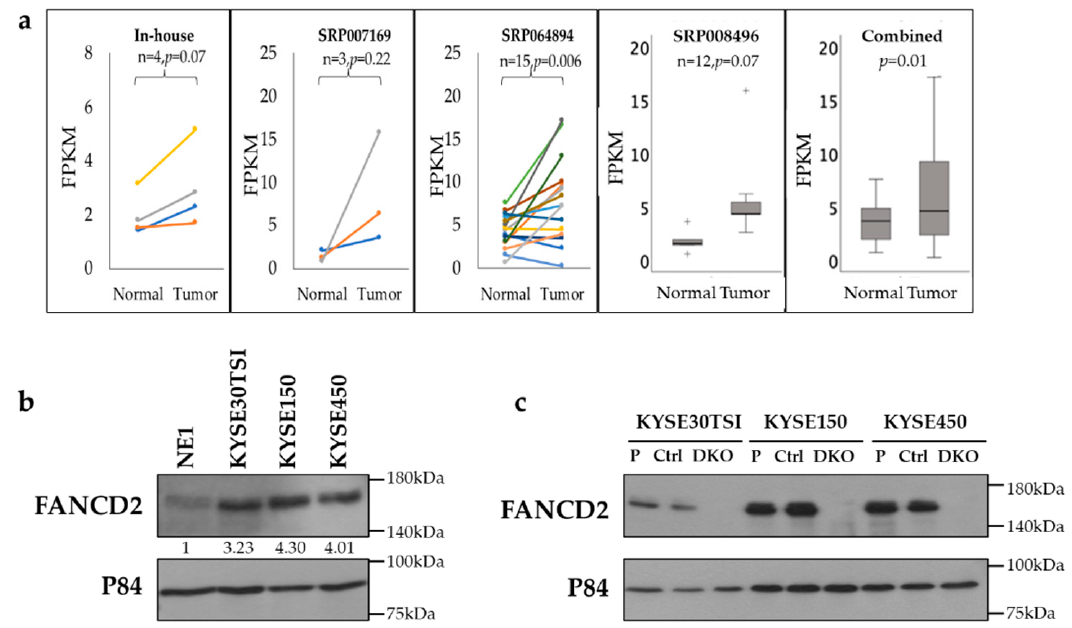
Figure 1. FANCD2 expression in ESCC tissues and cell lines. ( a ) FANCD2 RNA expression was significantly upregulated in ESCC compared to the normal tissues using RNA sequencing and is presented as Fragments Per Kilobase Million (FPKM). + , outlier data. ( b ) FANCD2 protein expression was upregulated in three ESCC cell lines compared with the NE1 cell line. The numbers show the ratios of FANCD2 band intensity in ESCC cell lines relative to that in the NE1 cell line, normalized to the p84 loading. ( c ) Confirmation of endogenous FANCD2-KO in ESCC cell lines by Western blotting. P, parental; Ctrl, control; DKO, FANCD2 knockout; p84, loading control. 3.2. Depletion of FANCD2 Protein Expression Inhibits In Vivo Tumor Growth and Metastasis CRISPR-mediated FANCD2 protein expression depletion was performed in three ESCC cell lines resulting in almost complete knockout of FANCD2 (FANCD2-KO) protein expression (Figure 1c and Figure S2). To determine the role of FANCD2 on ESCC primary tumor growth, the subcutaneous tumorigenicity nude mouse model was utilized. Significant suppression of tumor growth was observed in FANCD2-KO cells, as compared to control cells in all three cell lines tested (Figure 2a). To determine the role of FANCD2 on ESCC tumor metastasis, the tail-vein experimental metastasis model in nude mice was utilized using KYSE150Luc cells. An obvious reduction in lung metastasis formation was observed after three weeks in the FANCD2-KO group in contrast to the control group (Figure 2b,c). Mice bearing FANCD2-KO cells showed significantly better survival than the mice bearing control cells (Figure 2d; Log Rank p = 0.007). In addition, fewer and smaller metastases were observed in the lung sections of mice bearing FANCD2-KO cells (Figure 2e,f). These findings strongly indicate a role of FANCD2 in supporting ESCC tumor